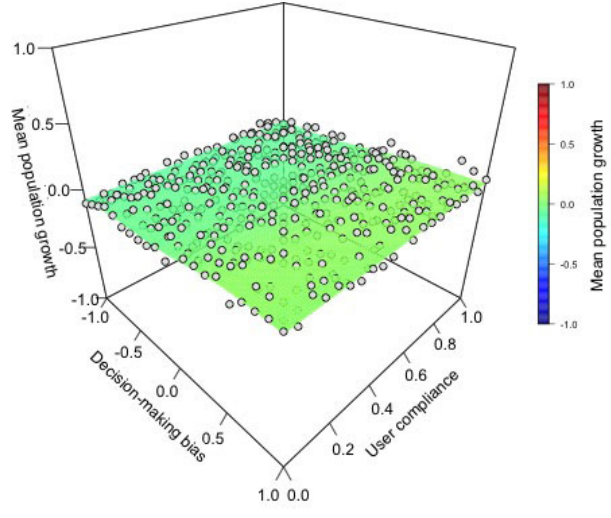
Fig. 2 . Mean population growth over a 10-year